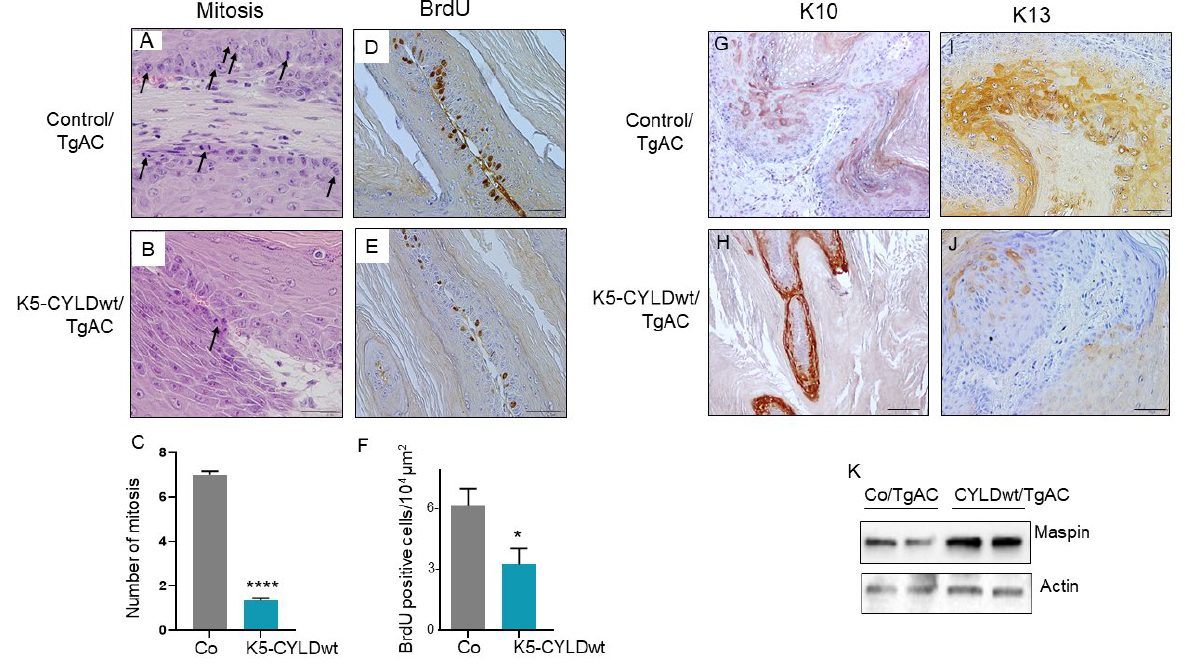
Figure 7. K5-CYLDwt/TgAc tumors are less proliferative and more differentiated. ( A , B ) Representative pictures showing increased number of mitosis in Control/TgAC tumors. ( C ) Graph showing the significant increase in the number of mitosis/ µ m 2 in Control/TgAC tumors. ( D , E ) Immunostaining with an anti-BrdU antibody showing increased number of proliferating cells in Control/TgAC tumors ( D ) than in K5-CYLDwt/TgAC tumors ( E ). ( F ) Graph showing the diminished number of BrdU-positive cells/µm 2 in K5-CYLDwt/TgAC tumors. ( G , H ) Observe the weak and discontinuous expression of K10 in Control/TgAC tumors ( G ) versus the strong and continuous expression in K5-CYLDwt/TgAC tumors ( H ). ( I , J ) K13 immunostaining. Note the induction of K13 in Control/TgAC tumors ( I ), while only sporadic K13 positive cells were detected in K5-CYLDwt/TgAC tumors ( J ). ( K ) WB showing increased Maspin expression in K5-CYLDwt/TgAC tumors. Data are shown as mean ± SEM; **** p < 0.0001; * p < 0.05 by two-tailed t-test with Welch’s correction. Mitosis: n = 79 tumors from five different Control/TgAC mice; n = 32 tumors from five different K5-CYLDwt/TgAC mice. BrdU staining: seven tumors from five mice of each genotype. Scale bars: 25 µm ( A , B ); 60 µm ( D , E ); 50 µm ( G – J ).